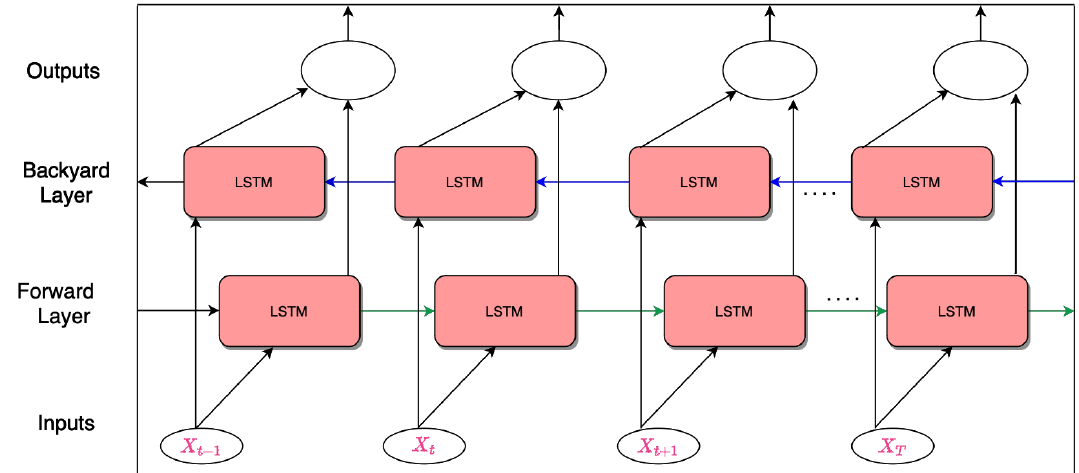
Figure 10. The structure of a bi-directional LSTM (Bi-LSTM)